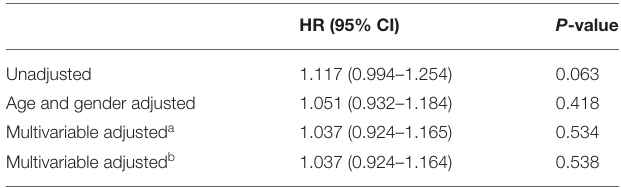
TABLE 4 | Hazard ratios and 95% CIs for sleep midpoint associated with MI on